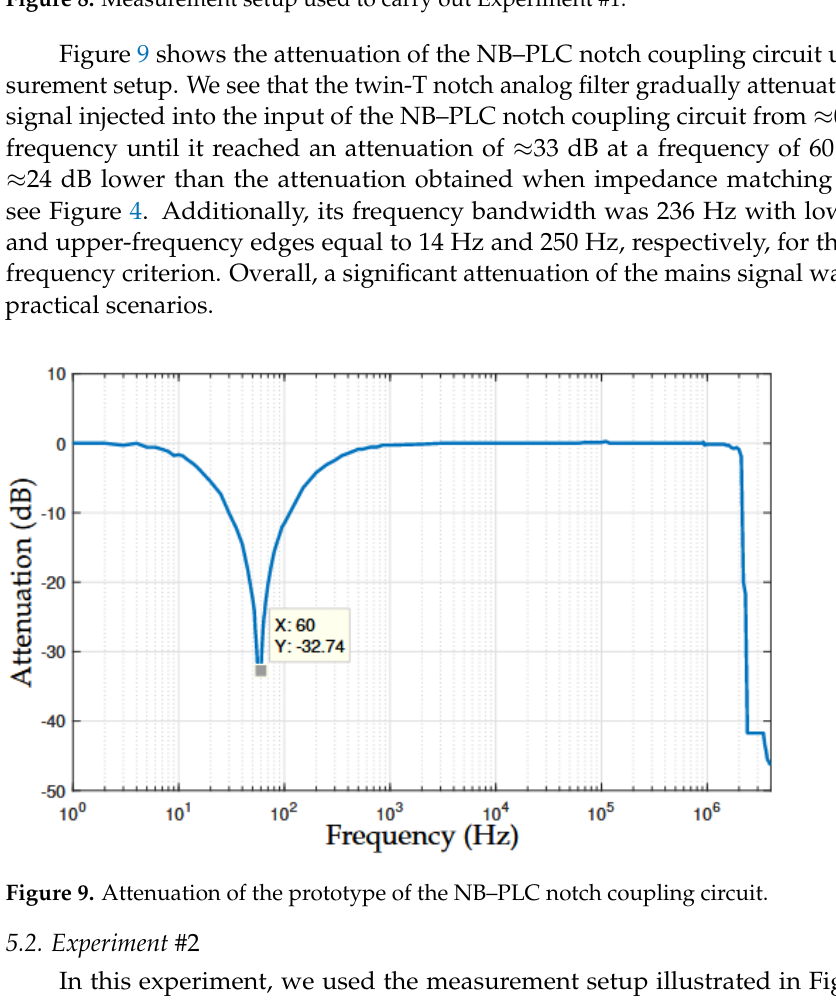
Figure 8. Measurement setup used to carry out Experiment #1.